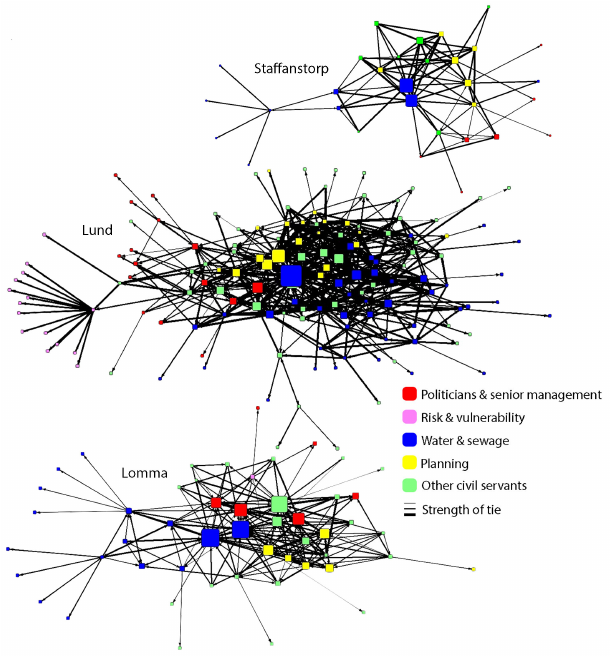
Fig. 2 . Local control of resources in networks of actors mitigating flood risk within the three studied municipal administrations. Node size = local control of resources (in- degree centrality). Tie thickness = normalized sum of importance of inputs. Note that node sizes and tie thicknesses are relative within each network and cannot be compared between